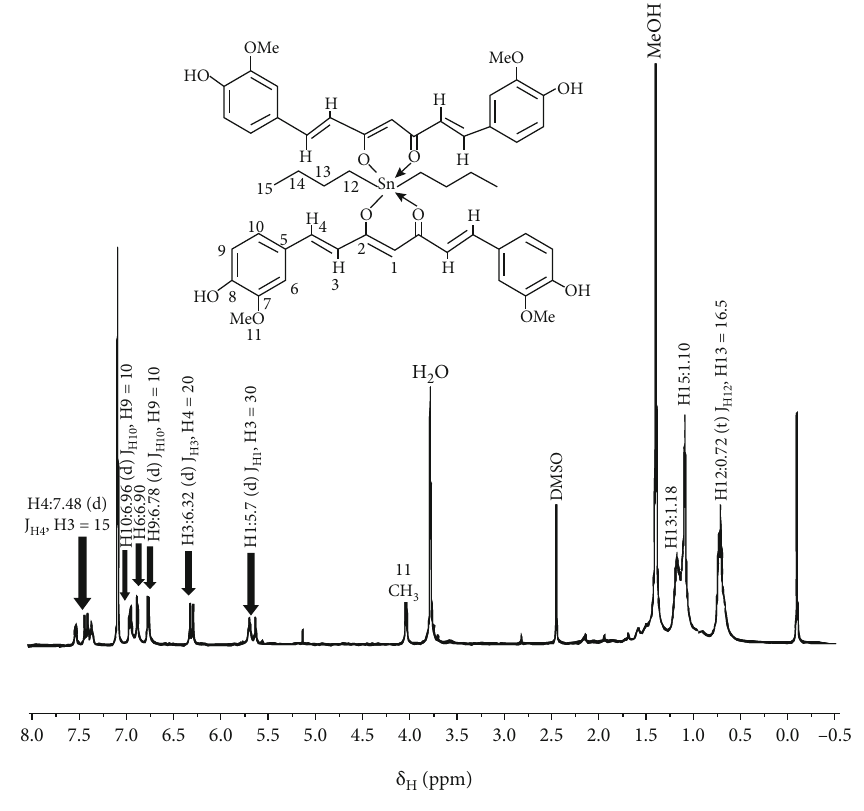
Figure 3: 1 H NMR spectrum in DMSO d Table 1: 1 H NMR in DMSO d